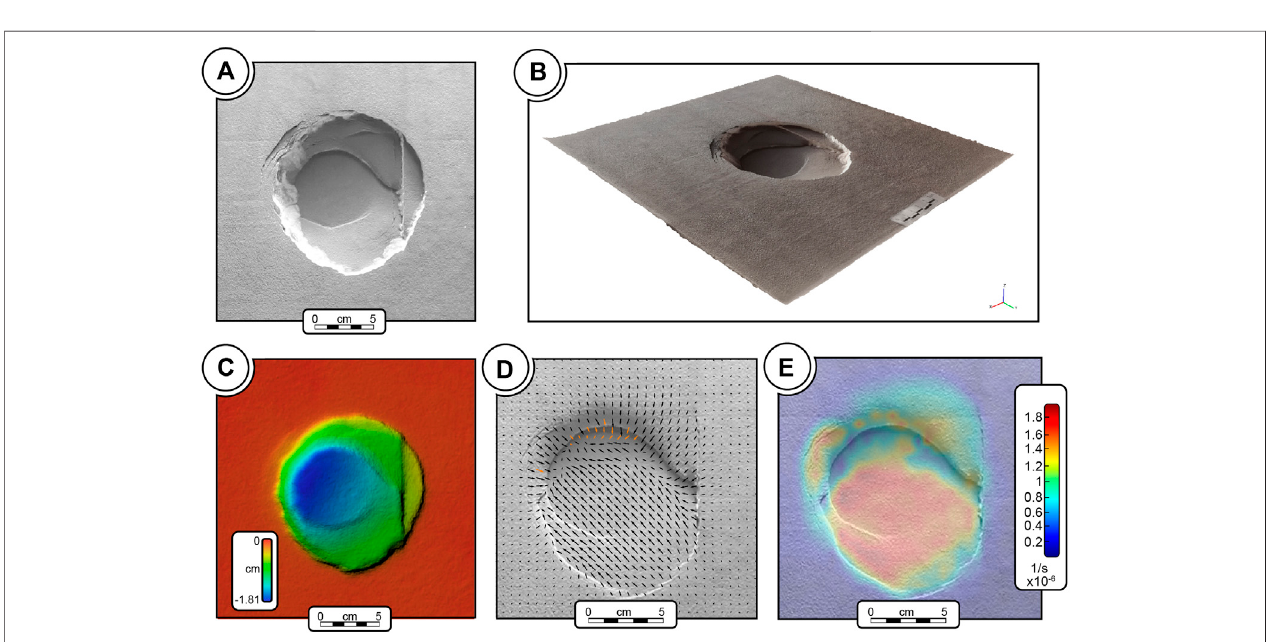
FIGURE 2 | Example of data provided and possible outputs derived from the dataset (Model ODCC-1). (A) Top view image acquired during model deformation. Theseimages areprovided asseparate.jpg fi lesasinputforDPIVanalysisormountedinamovietoshowthecomplete modeldeformation. (B) 3Dperspectiveviewofa virtual model, fully navigable to investigate model deformation. (C) Digital Elevation Model. (D,E) Examplesof DPIV analysisobtained with the PIVlab tool, particularly (D) velocity vectors and (E) velocity magnitude. These outputs can be obtained from the analysis of the provided input fi les.